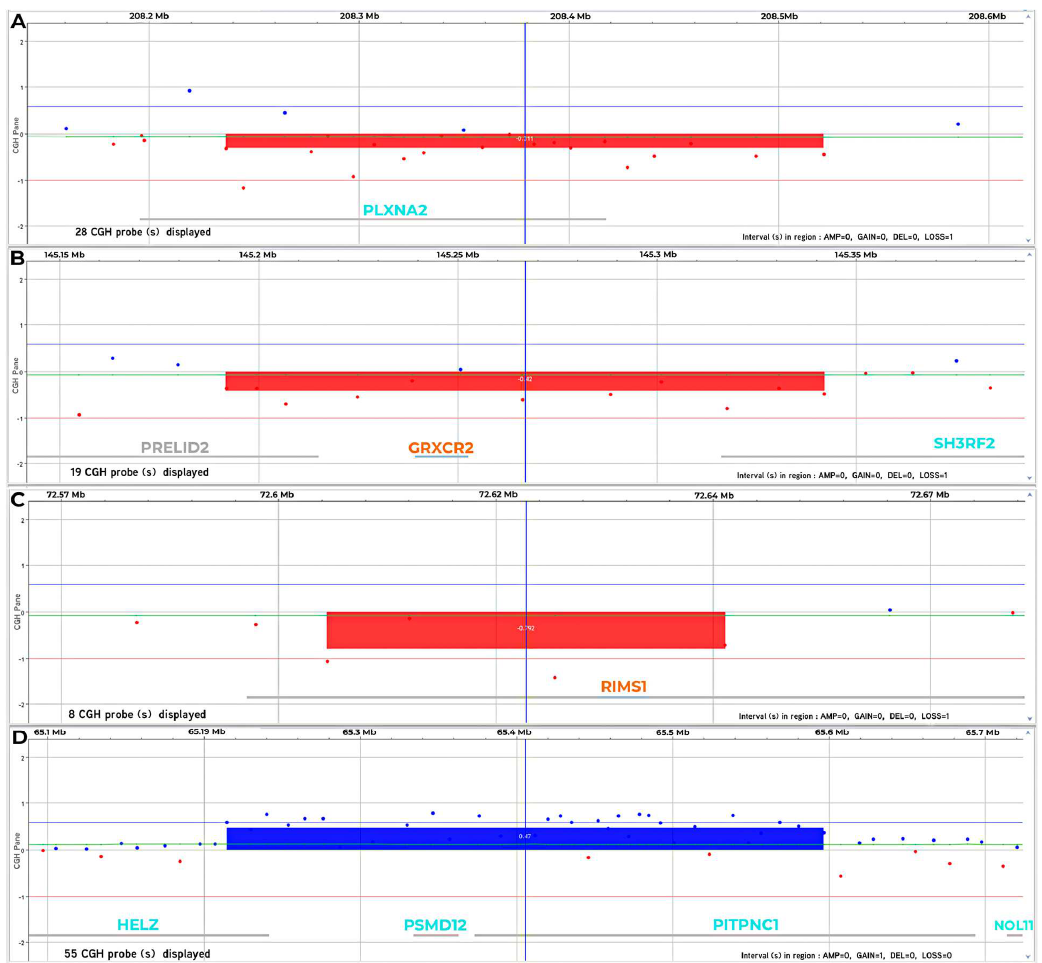
Figure 2. ( A ) a-CGH profile of chromosome 1. This analysis shows a heterozygous de novo deletion in 1q32.2 region of 284.57 kb involving PLXNA2 . ( B ) a-CGH profile of chromosome 5. The analysis shows a heterozygous de novo deletion in 5q32 region of 150.23 kb, partially involving PRELID2 , GRXCR2 and partially SH3RF2 . ( C ) a-CGH profile of chromosome 6. This analysis shows a hetero- zygous de novo deletion in 6q13 region of 45.85 kb, involving RIMS1 . ( D ) a-CGH profile of chromo- some 17. The analysis shows a heterozygous duplication of maternal origin in the 17q24.2 region of 381.85 kb partially involving HELZ , PSMD12 , partially PITPNC1 . Results are interpreted as log2